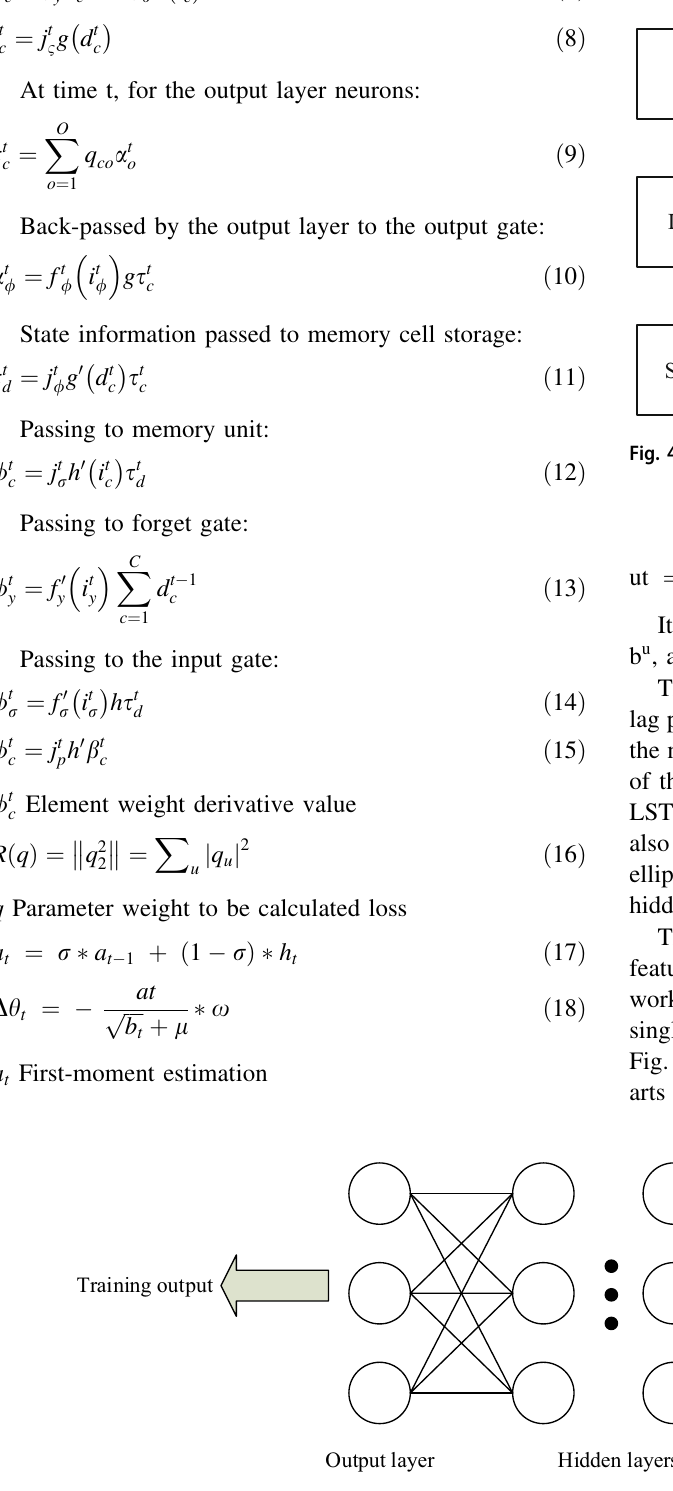
Fig. 3 LSTM network structure schematic